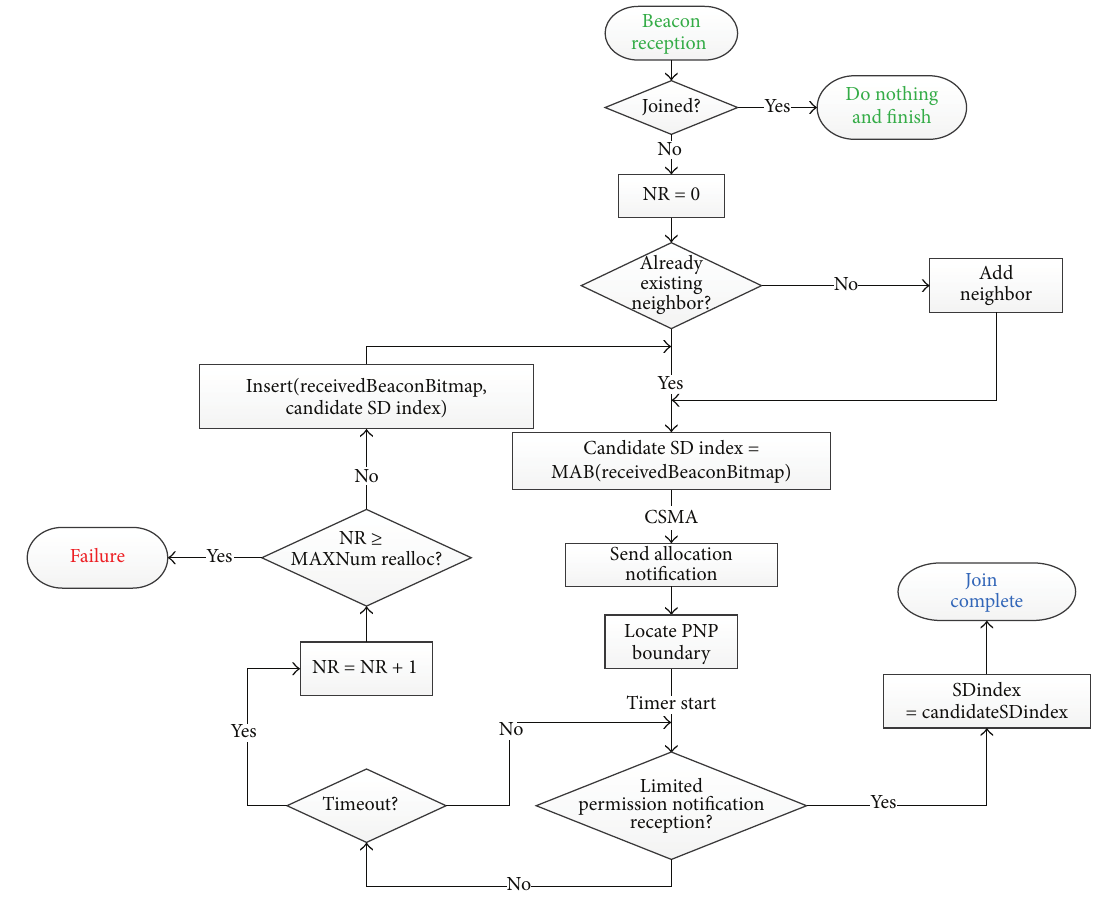
Figure 12: E-DSME beacon